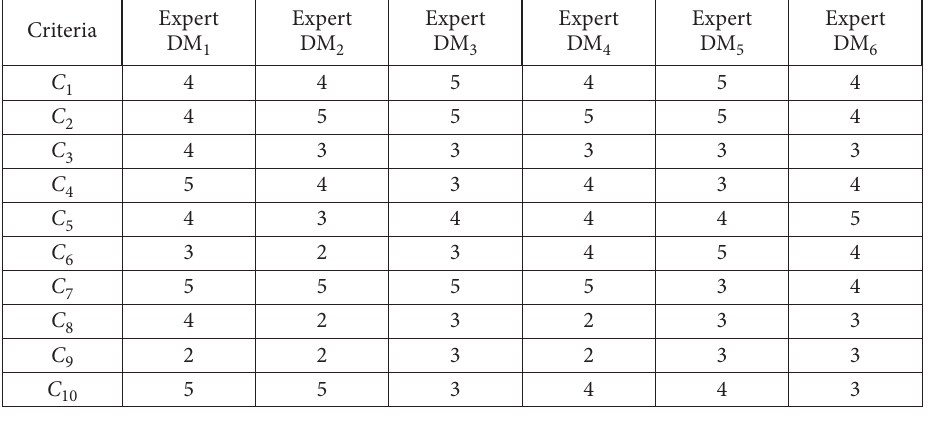
Table 3. Degree of importance of weights assigned by six experts to the 10 criteria Criteria